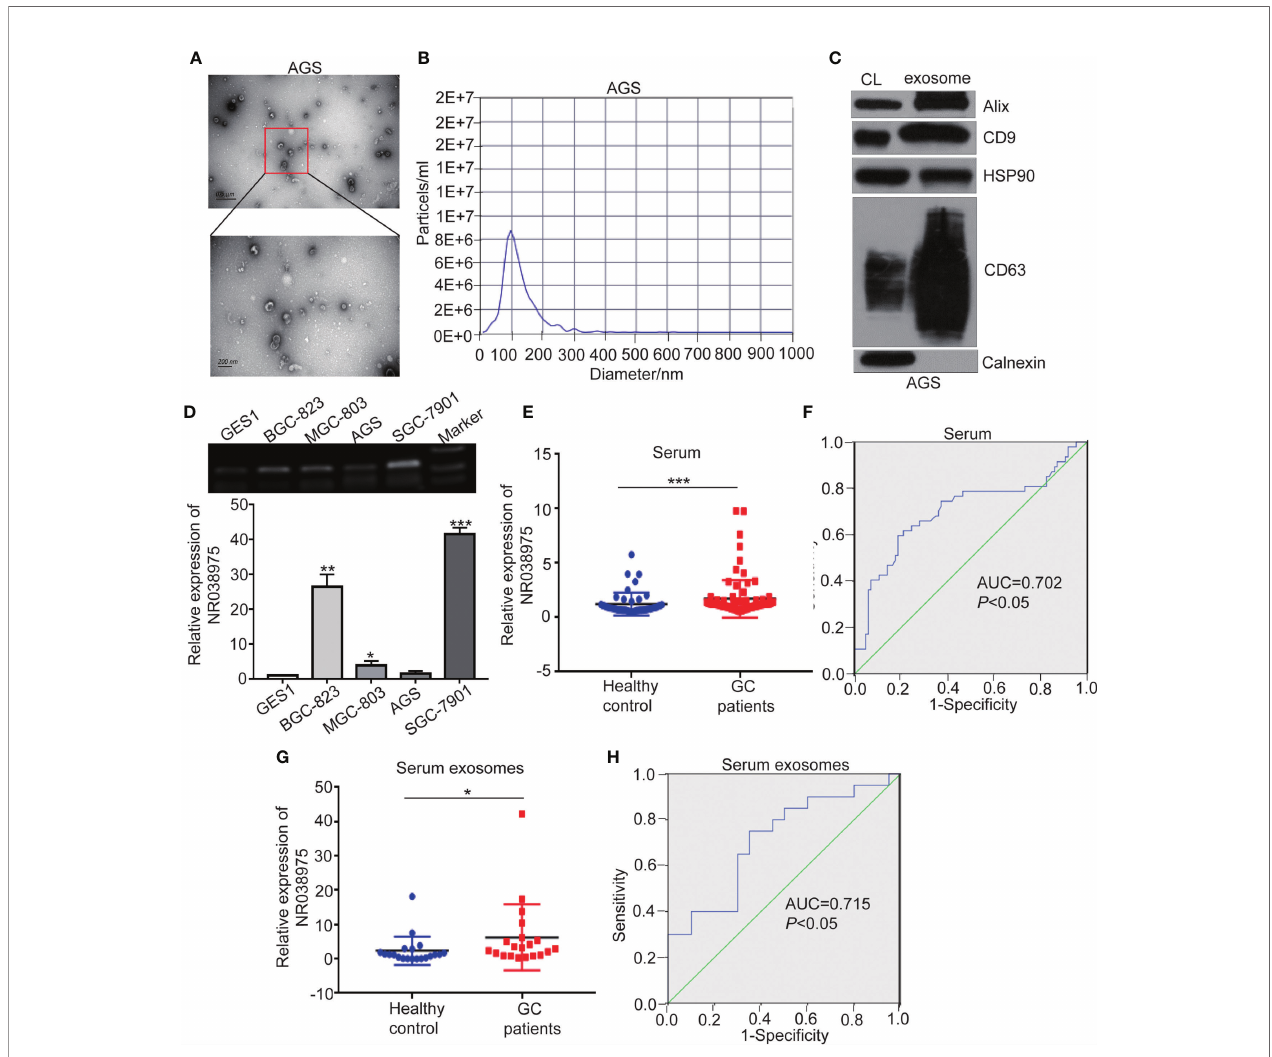
FIGURE 7 | NR038975 exists in gastric cancer (GC) cell-derived exosomes and is upregulated in the serum of GC patients. (A) Representative TEM images of exosomes secreted by AGS cells. (B) Nanoparticle tracking analysis (NTA) of the size distributions and numbers of exosomes derived from AGS cells. (C) The markers of exosomes were detected by Western blot. (D) NR038975 expression in exosomes isolated from four GC cell lines and one immortalized normal gastric epithelial cell line (GES1) was detected by RT-PCR and qPCR. (E) NR038975 expression levels in serum of GC patients and healthy controls. (F) Receiver operating characteristic (ROC) curves for the diagnostic value of serum NR038975 in GC. (G) NR038975 expression levels in serum exosomes of GC patients and healthy controls. (H) ROC curves for the diagnostic value of serum exosomal NR038975 in GC. *p < 0.05, **p < 0.01, ***p <